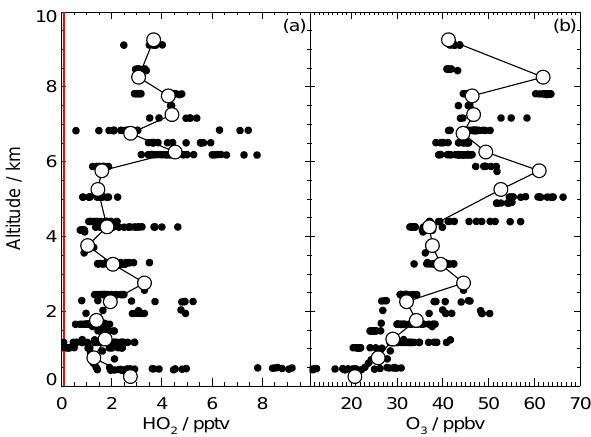
Fig. 18. Night-time Altitude Profiles of (a) HO 2 (pptv, black) and maximum HO 2 limit of detection (pptv, red) for the night-time dataset. (b) O 3 (ppbv). Median values for 500m altitude bins are shown as white